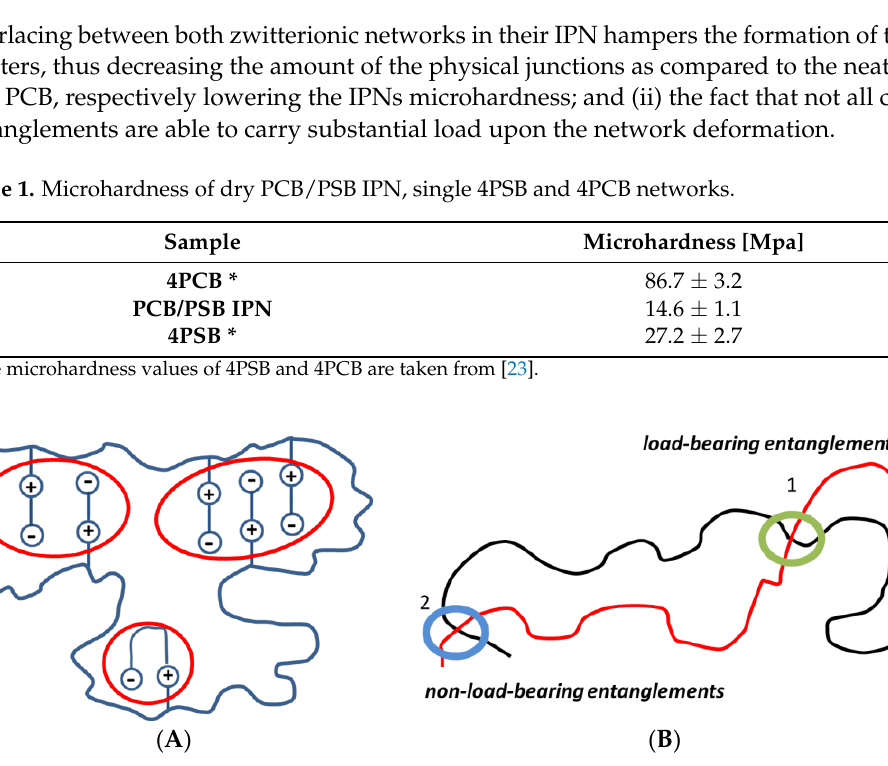
Table 1. Microhardness of dry PCB/PSB IPN, single 4PSB and 4PCB